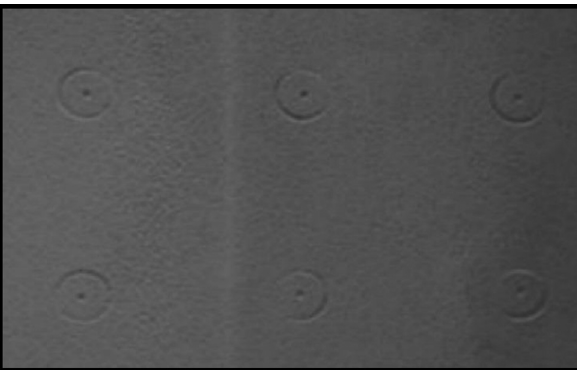
Figure 25: CS coating on simulated fuselage fasteners [ 76 ] .